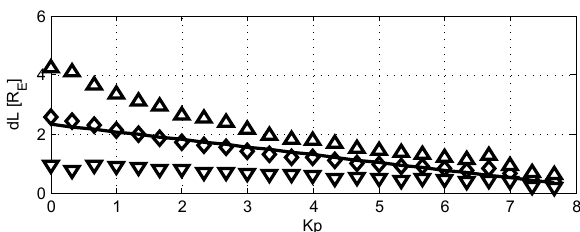
Figure 7. Average width of the transition zone ( dL ) as a function of Kp ( χ >90 ◦ ).